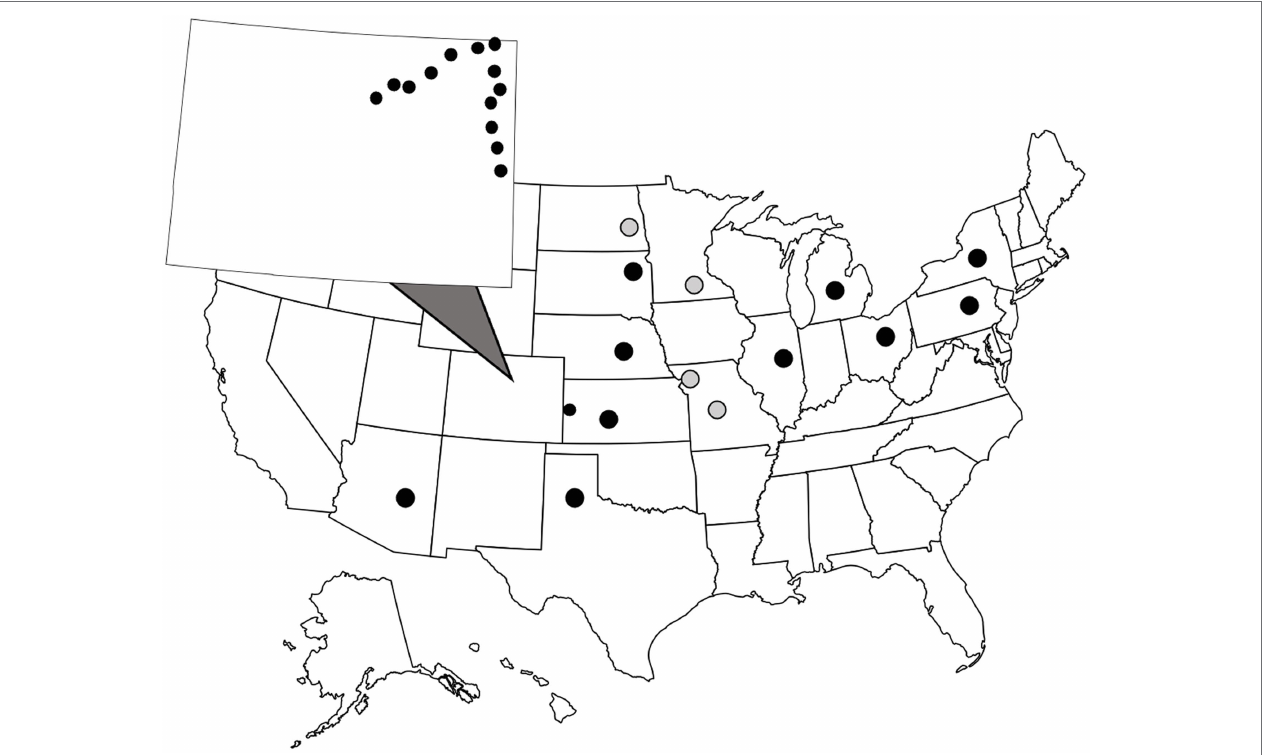
FIGURE 1 | Sample locations of wild, adult Diabrotica virgifera virgifera (black dots) and D. barberi (gray dots). Beetles were collected from cornfields during late July to early August. Colorado is zoomed out with small circles showing close-proximity sampling locations (note one location is across the border in Kansas). Each dot consists of one sample site where eight individual beetles were